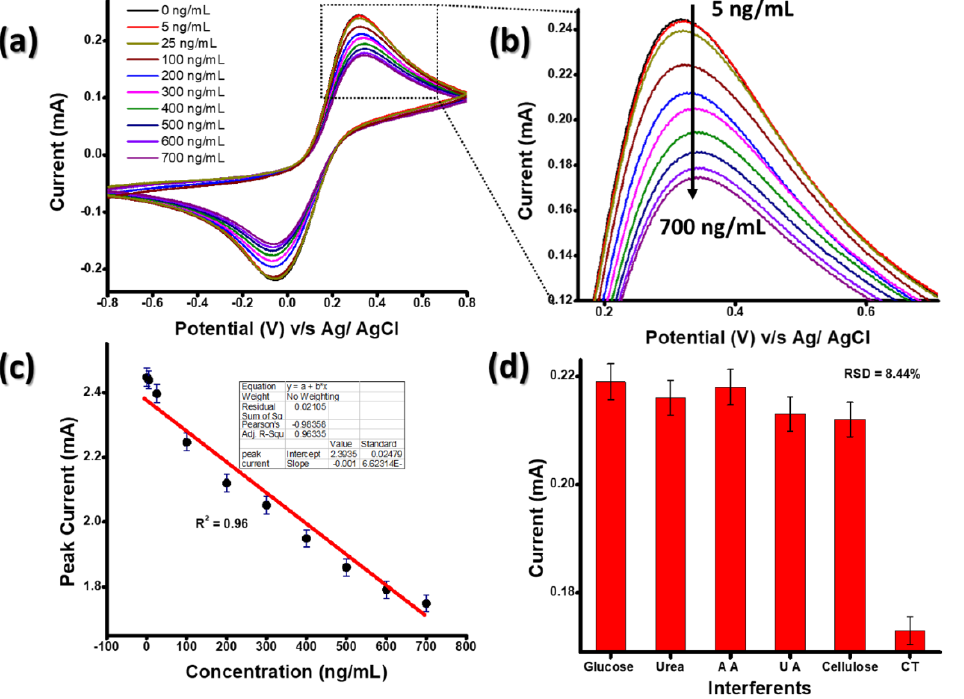
Figure 7. ( a , b ) The electrochemical response study of BSA/anti-CT/APTES-Gd 2 O 3 /ITO immunoelectrode for different concentration of CT, ( c ) the calibration plot and ( d ) the interference study of BSA/anti-CT/APTES-Gd 2 O 3 /ITO.